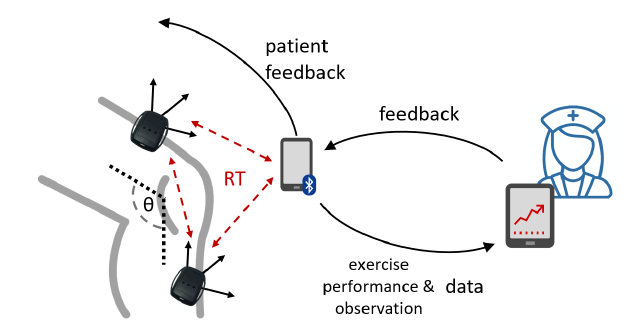
Figure 1. Digital rehabilitation scenario: knee motion sensors for exercise monitoring and real-time feedback. In this scenario the knee sensors interact in real-time with the patient’s application, which in turn provides immediate feedback, and provides information to the health professional about the exercise performance.